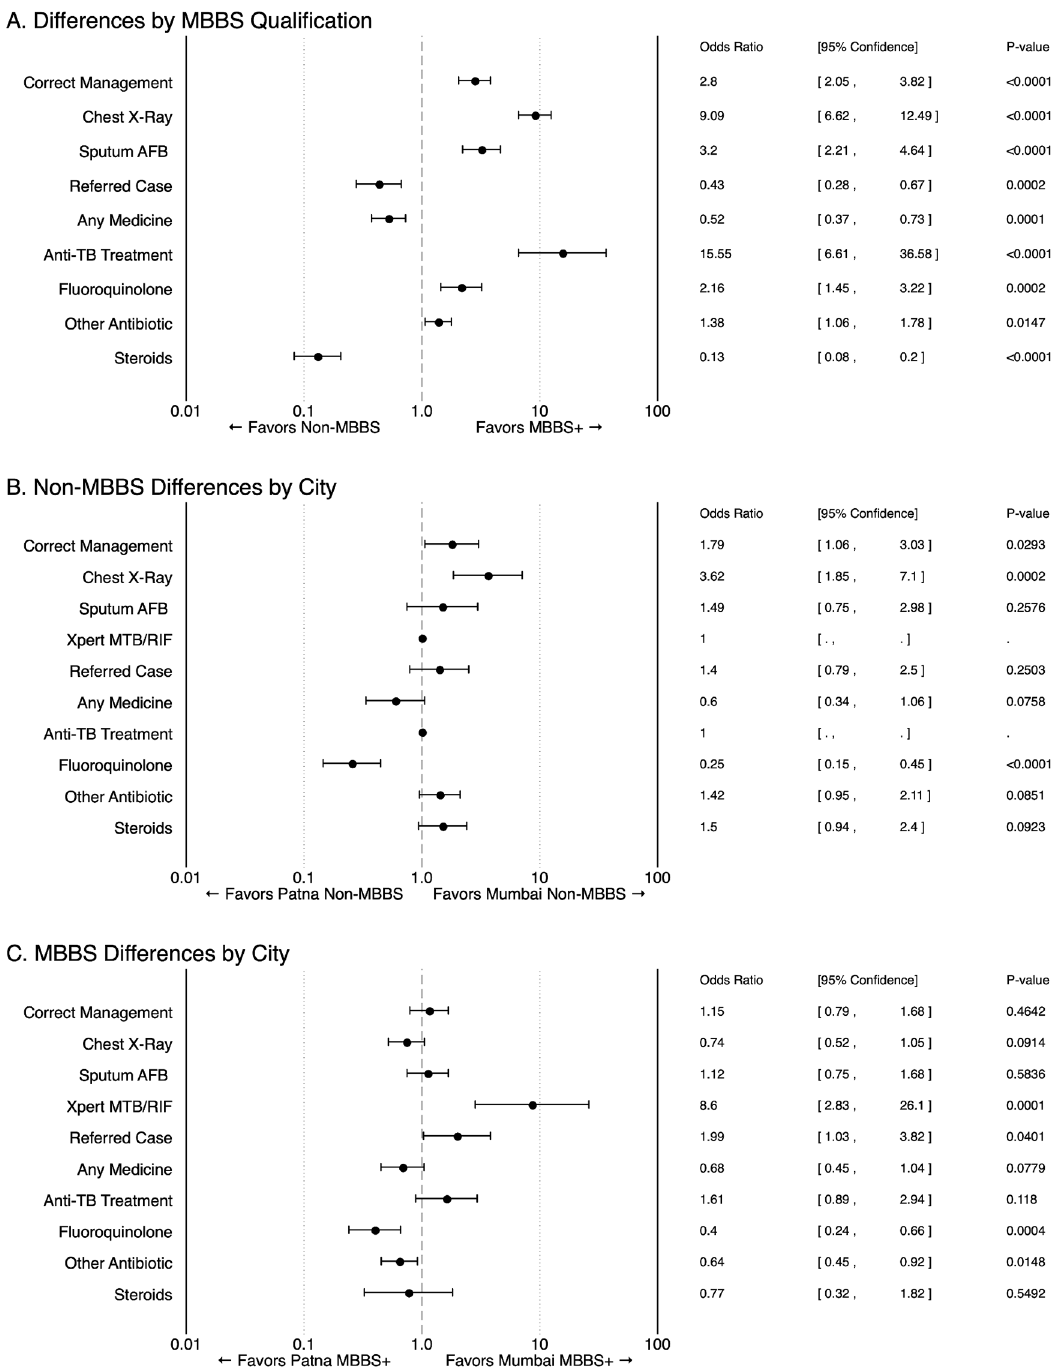
Fig 3. Quality of care differences by provider qualification and location. Estimated ORs between various groups of providers, for the frequency in which the indicated management action is observed across all case scenarios. Panel A reports differences by MBBS qualification level, pooled across all observations. This regression includes controls for city setting and case scenario ( N = 2,602). Panels B and C report similar ORs estimated across cities, stratified by MBBS qualification ( N = 1,448 and 1,154, respectively). These regressions include controls for case scenario. AFB, acid-fast bacilli; MBBS, Bachelor of Medicine, Bachelor of Surgery; OR, odds ratio; TB, tuberculosis; Xpert MTB/RIF, Xpert Mycobacterium tuberculosis/Rifampicin, also known as GeneXpert.